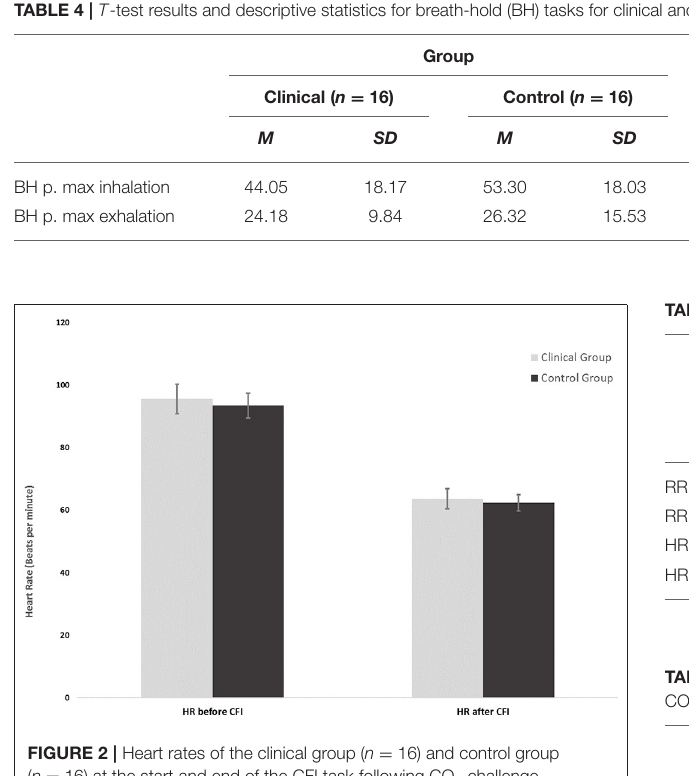
change in HR [ F (1,30) = 1.861, p = 0.183, η 2 = 0.058]. In addition,